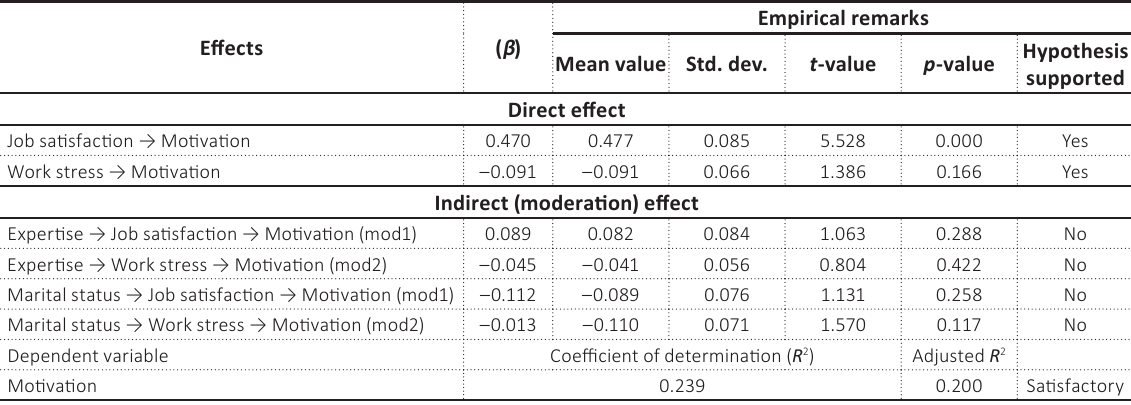
Table 5. Path coefficient: Direct and Indirect relationship